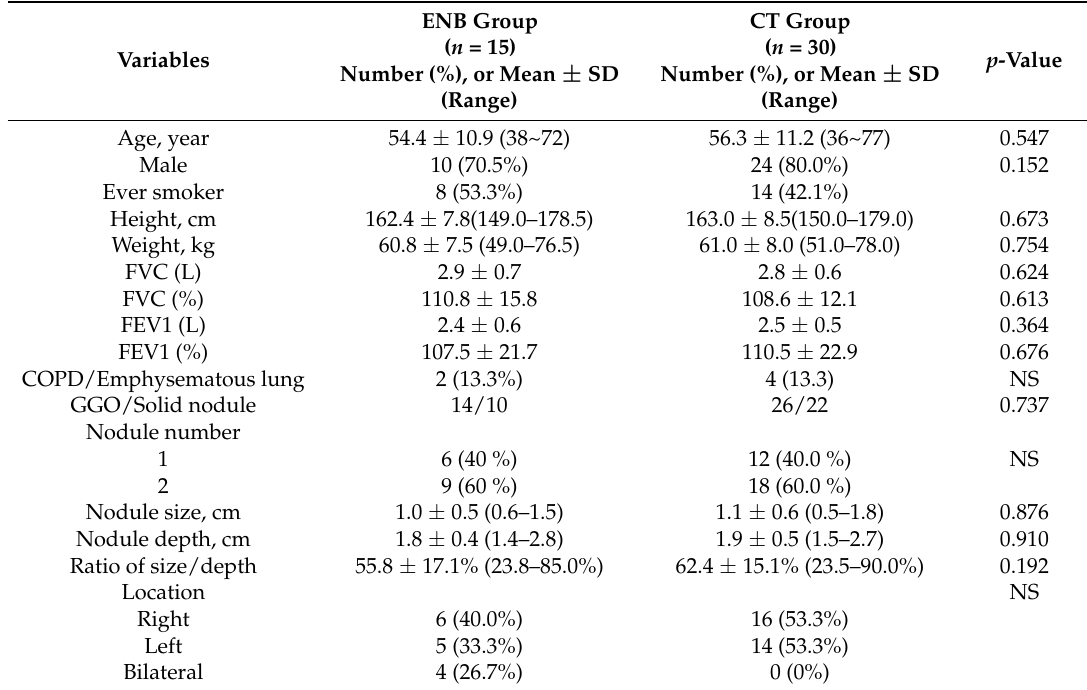
Table 1. Clinical characteristics and demographics of two matched groups.